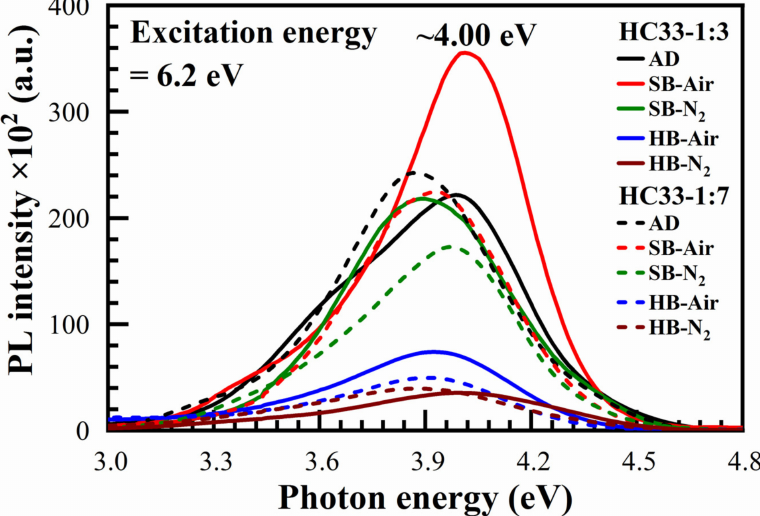
Figure 22. UV-induced PL spectra of 33 wt% porogen content films (numbered as HC33) for 1:3 and 1:7 benzene bridge ratio materials as-deposited (AD), soft baked (SB) at 150 ◦ C for 30 min both in air (SB-Air) and N 2 (SB-N 2 ), hard bake (HB) at 400 ◦ C for 30 min air (HB-Air) and 60 min in N 2 (HB-N 2 ) under 6.2 eV